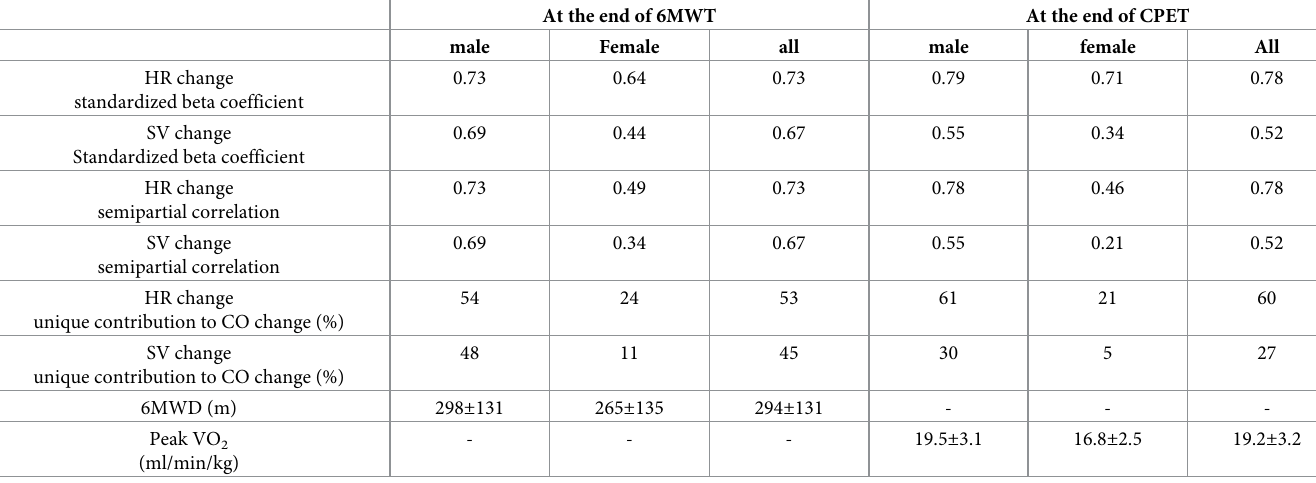
Table 6. Contribution of unique changes in HR and SV to changes in CO (Multiple linear regression analyses using change in CO as an outcome